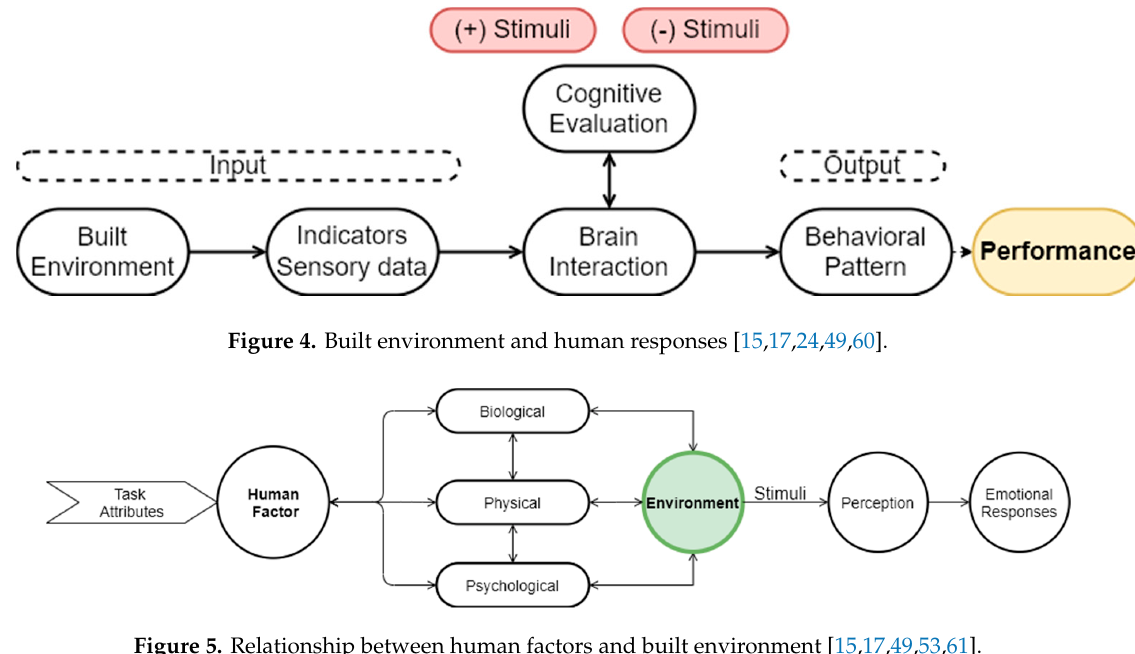
Figure 5. Relationship between human factors and built environment [15,17,49,53,61].